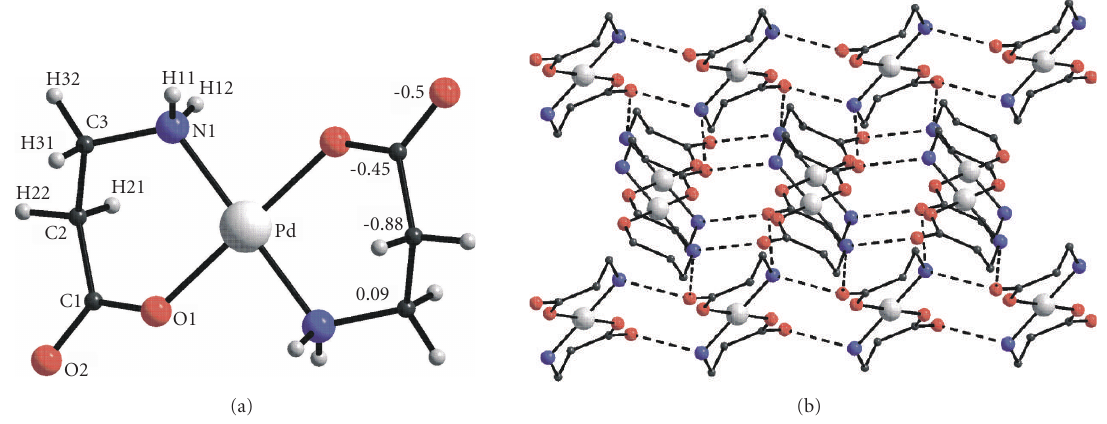
Figure 2: Molecular structure of trans -[Pd( β -Ala) 2 ], atomic numbering, and deviations of atoms ( ˚A) from the plane of the coordination square (a); view of the framework in the structure of complex